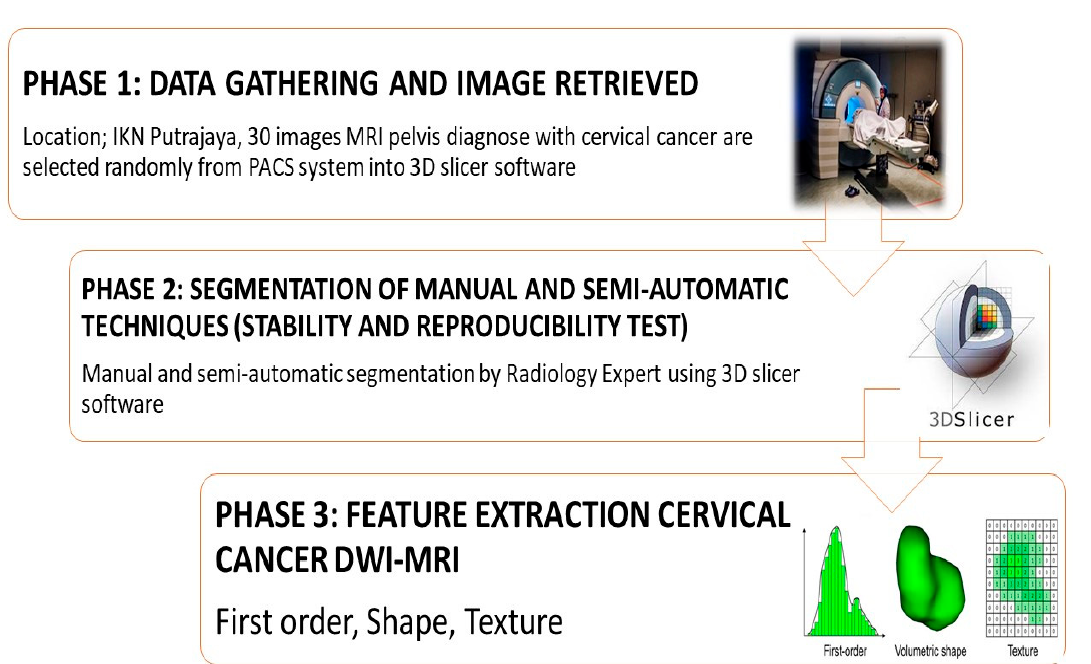
Figure 1. Research framework on stability and reproducibility of cervical cancer DWI-MRI.